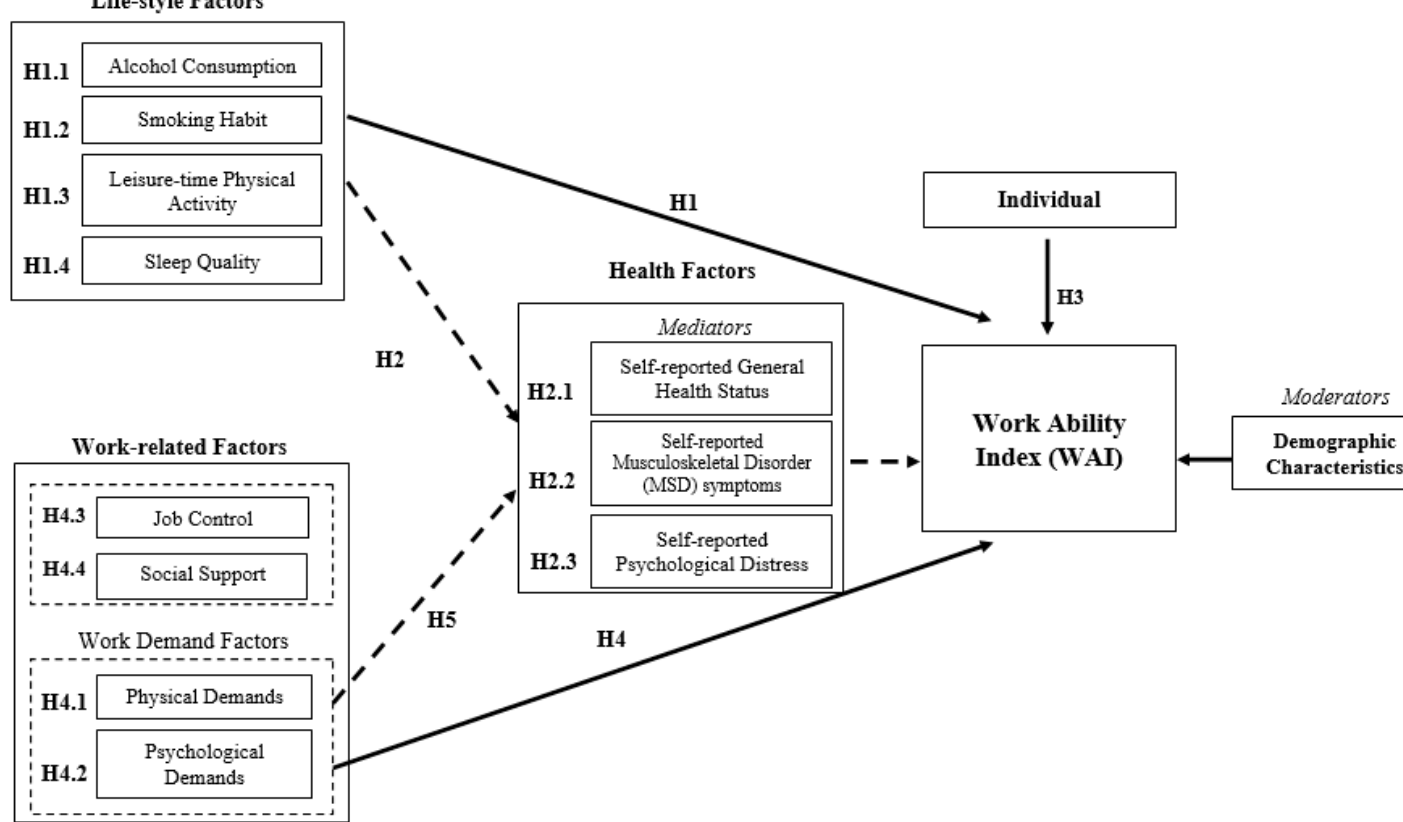
Figure 1 . The conceptual work ability model in the present study (Solid lines are direct effects and dashed lines are indirect effects).